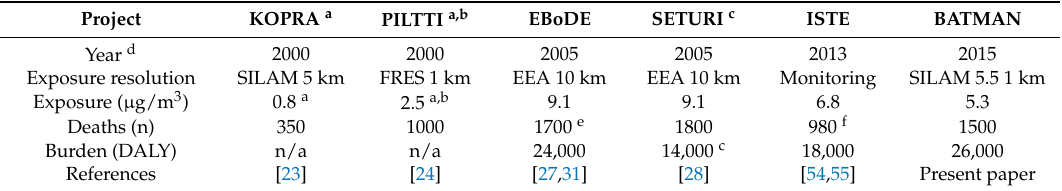
Table 6. National studies which have evaluated the health impacts of PM 2.5 in Finland.